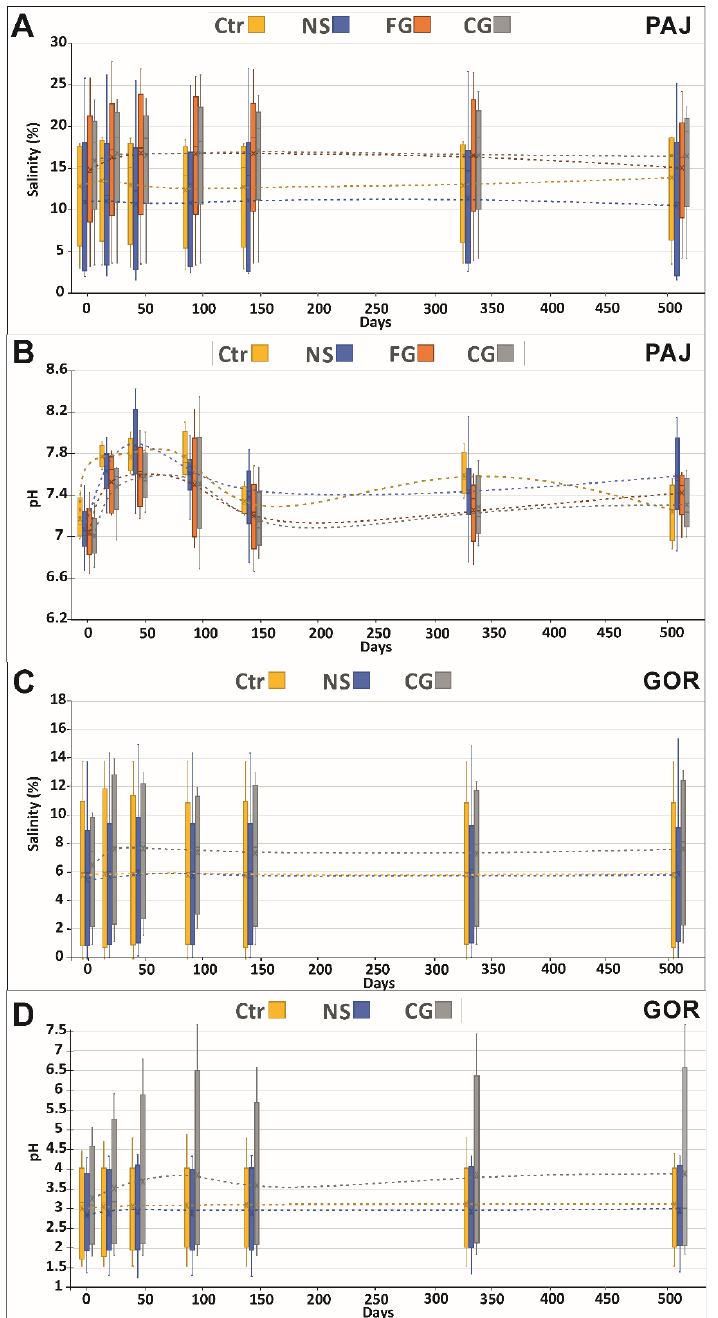
Figure 4. Physicochemistry of Salar de Pajonales (PAJ) ( A , B ) and Salar de Gorbea (GOR) incubations ( C , D ). Salinity ( A , C ) and pH ( B , D ) of controls (Ctr) and microbial mat samples with and without substrates (NS) over >500 days. The substrates used were fine gypsum (FG) and coarse gypsum (CG). Dashed red lines indicate delimitations of incubation stabilization and stabilized brines after the red lines. Note that different pH and salinity scales were used for PAJ and GOR incubations to maximize the visualization of stabilization fluctuations.